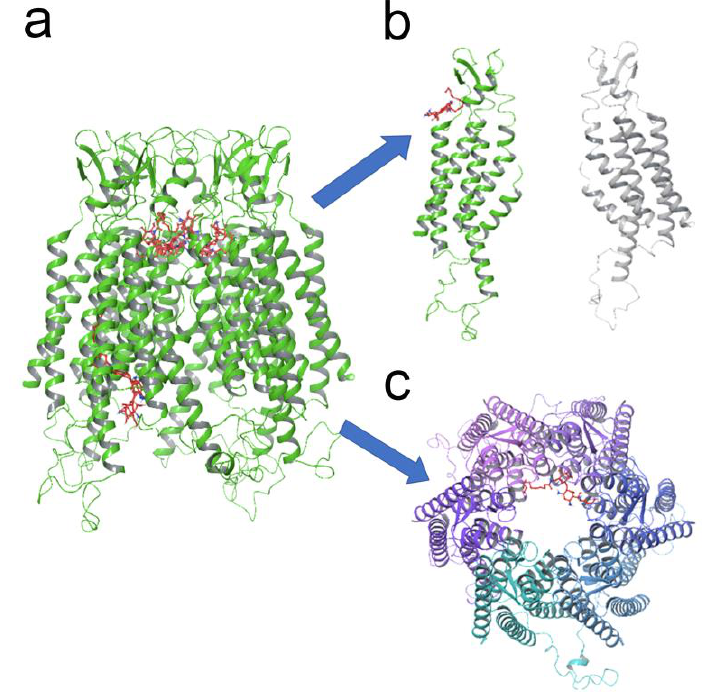
Figure 5. KI04 shows two putative binding sites with Cx46 hemichannels. Human Cx46 hemichannels were modeled in silico, and a molecular docking analysis was performed in the presence of